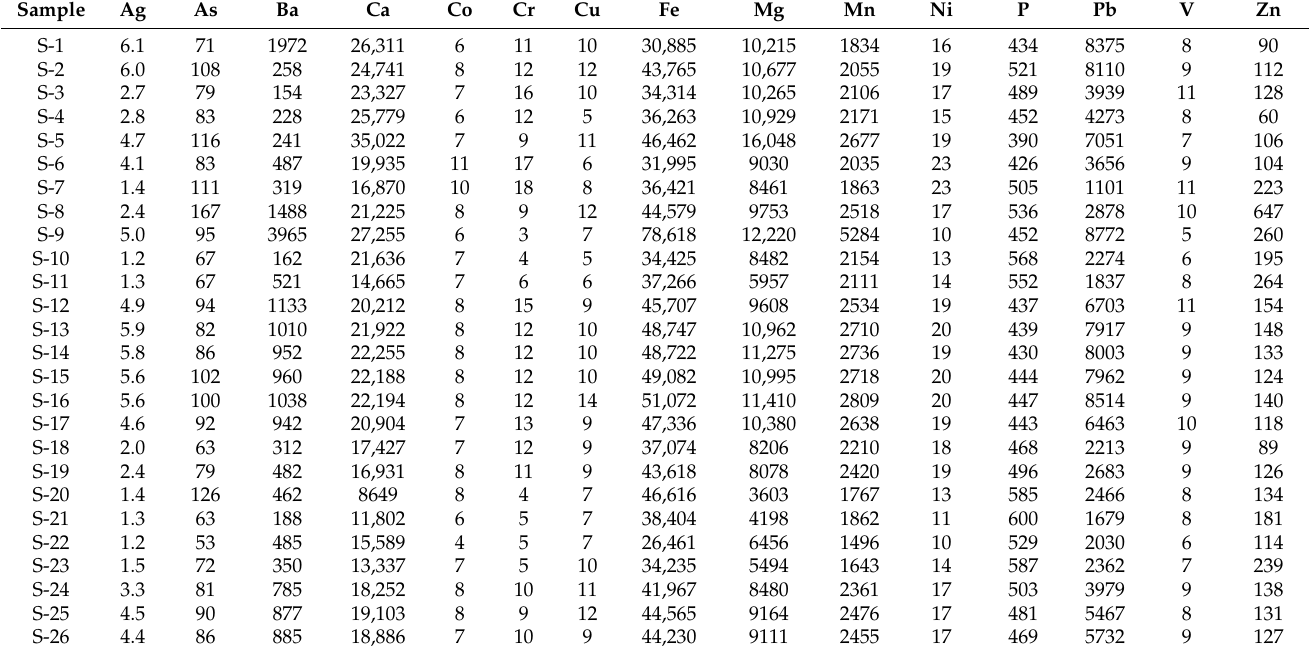
Table 2. The concentration (mg · kg − 1 ) of metal(oid)s in the samples of fines from the slope of the Federico mine dam.